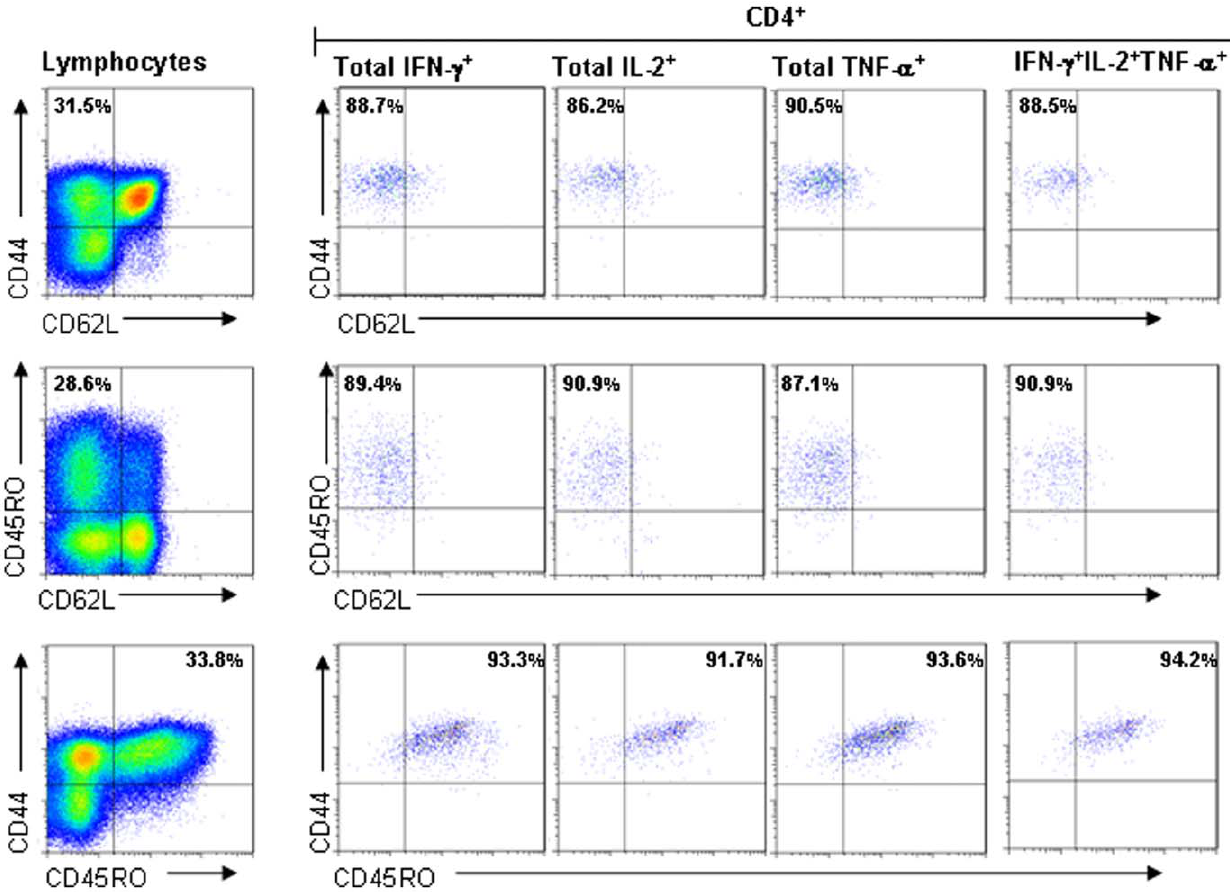
Figure 5. Characterisation of memory markers reveals a characteristic T EM phenotype for multifunctional CD4 + cells in naturally infected cattle. PBMC from naturally M. bovis infected cattle were stimulated with PPD-B and stained for production of cytokine by ICS flow cytometry. Histograms were first gated on singlet, live lymphocytes and gating strategies applied to allow phenotyping of cells for expression of CD44, CD45RO and CD62L. The quadrant gate defining expression of CD44 and CD62L (top panel), CD45RO and CD62L (middle panel) or CD44 and CD45RO (bottom panel) was determined using the total live-lymphocyte population, as shown for each surface marker combination in the histograms on the far left of the panel. This quadrant gating strategy was used to determine the surface phenotype of total CD4 + IFN- c + , CD4 + IL-2 + , CD4 + TNF- a + and triple functional CD4 + cells, as shown in the other histograms. The percentage of cytokine producing CD44 hi CD62L lo , CD45RO + CD62L lo and CD44 hi CD45RO + is shown for each of these CD4 + populations. The data is from one representative animal of 5 analysed.